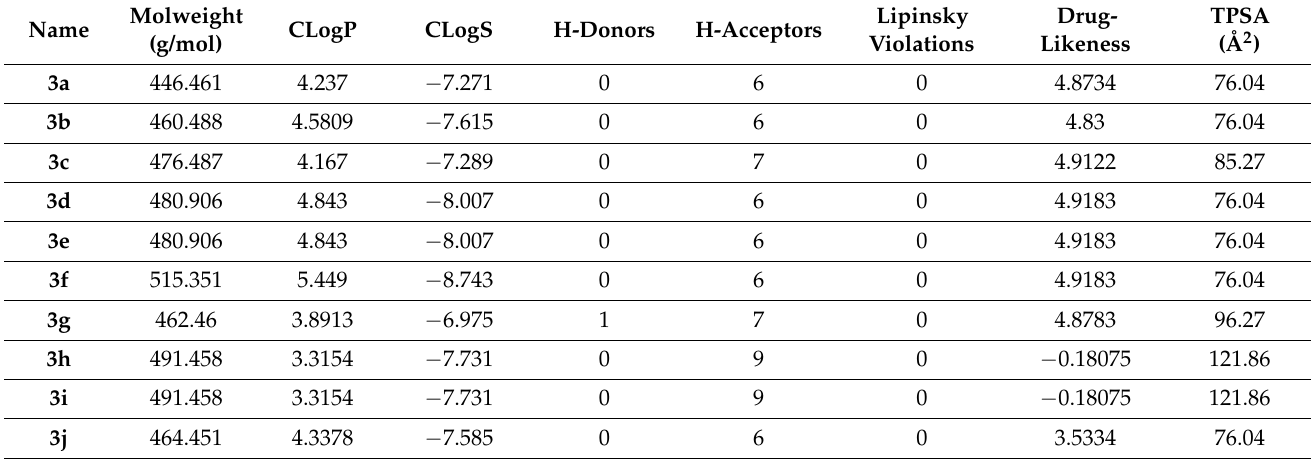
Table 3. Physicochemical properties of the synthesized compounds calculated by Data